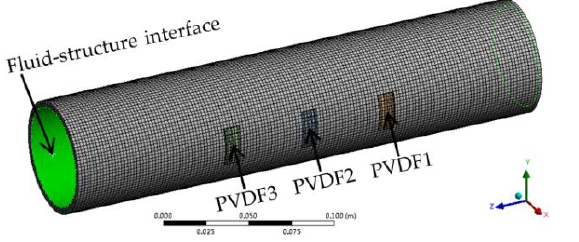
Figure 4. The finite element model of pipe and polyvinylidene fluoride (PVDF) piezoelectric thin 207 films. 208